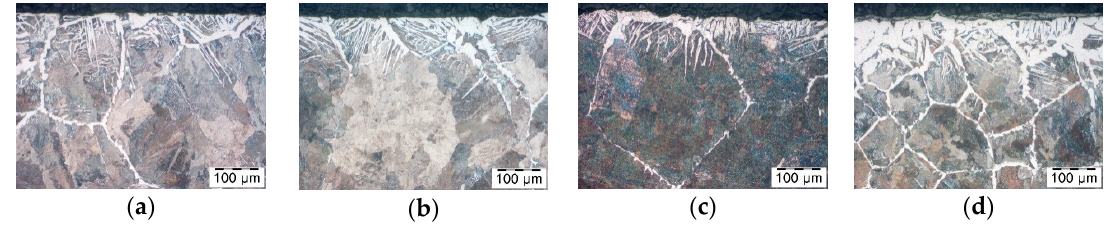
( b ) Figure 5. Microstructure of the surface layer of the steel bar C45: ( a ) when delivered and ( b ) after heated for forging and cooling in the air.